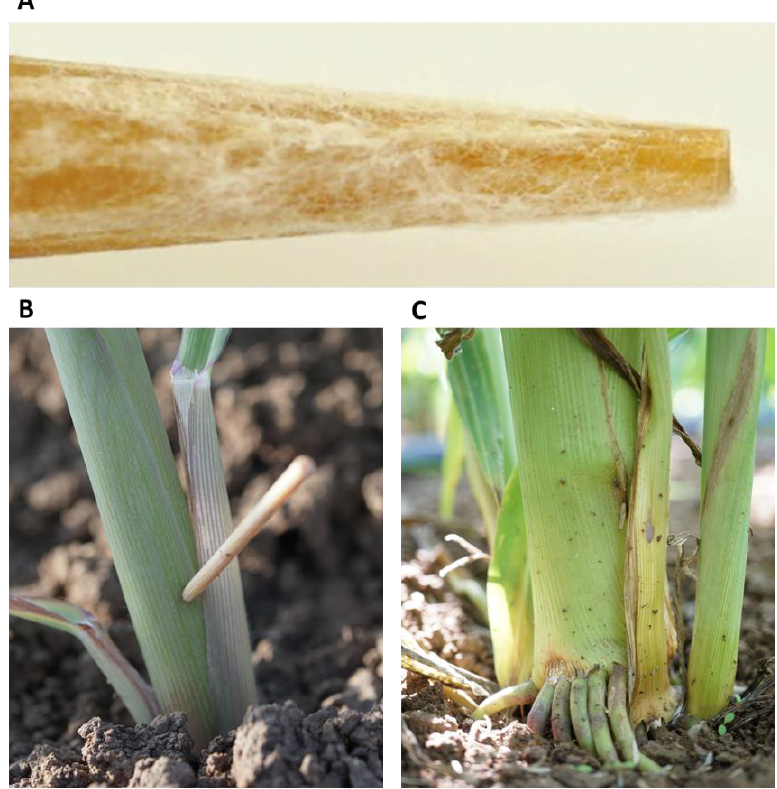
Figure 1. Field plants’ inoculation by stabbing with wooden toothpicks. This procedure was applied in the Gadash farm 2020 experiment. ( A ). Closeup photograph of the toothpick tip after 24 h of inoculation in the Magnaporthiopsis mayd is isolates’ mix. ( B ). Field inoculation of 20-day-old sprouts by toothpick stabbing at the aboveground portion of the stem. ( C ). The lower stem portion of the stab-inoculated 82-day-old plant. At this age, the wounded area is infected, populated with fungus, and shows disease symptoms, but the plant as a whole was less affected.